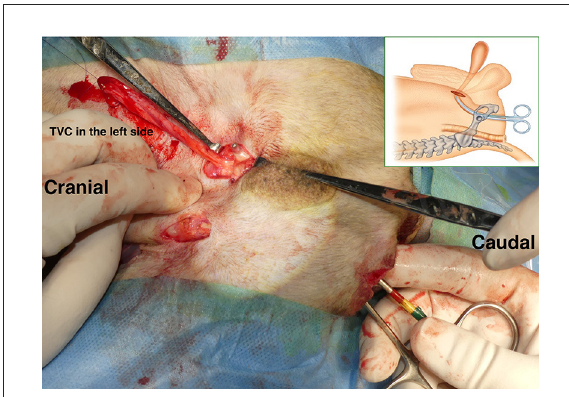
FIGURE3 Transposition of pedunculated tunica vaginalis communis (TVC) into the hernial foramen. After making the tunnel with an index finger, we put the forceps from the hernial foramen into the tunnel and advanced it toward the inguinal ring. The tips of the forceps penetrated outward from the abdominal wall near the inguinal ring. The stay suture placed at the tip of the TVC was then grasped with the forceps, and the TVC was transposed from the inguinal ring through the pelvic cavity into the hernia. An illustration shows the forceps passing through the pelvic cavity from the hernial foramen.